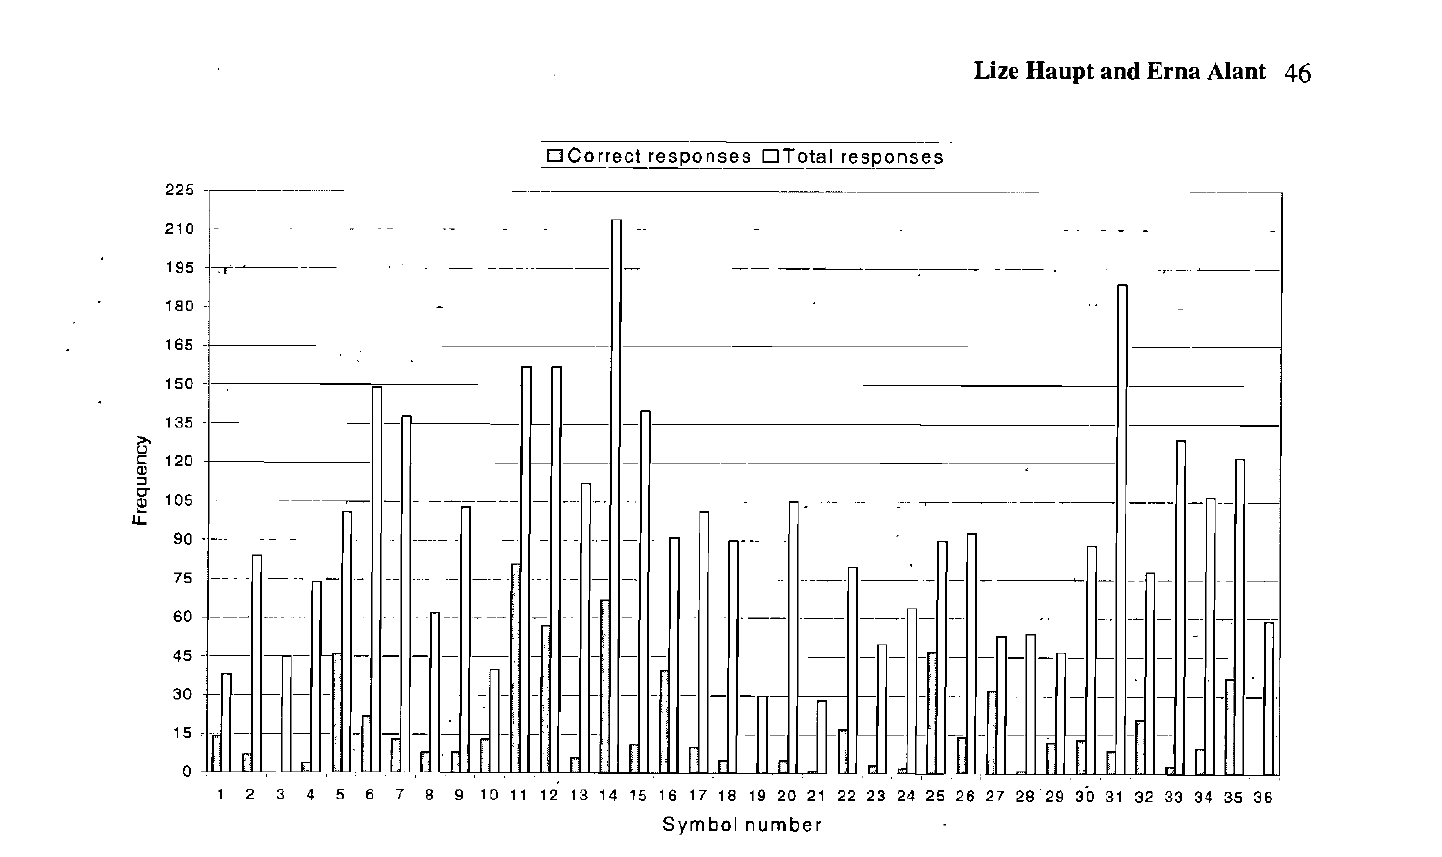
Figure I: Correct responses and total frequency of